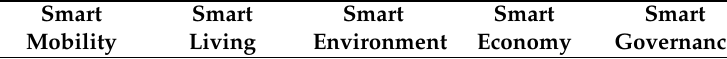
Table 1. Result of SLR search. Authors’ own